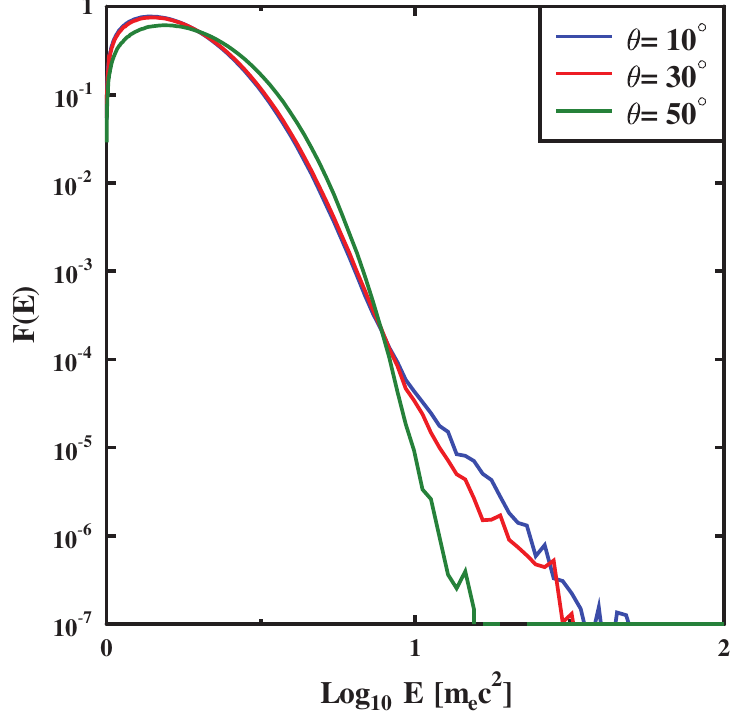
Figure 1. Electron distribution function in the shock downstream with initial parameters v = 0.3 c, σ = 0.0002 and different inclination angles.